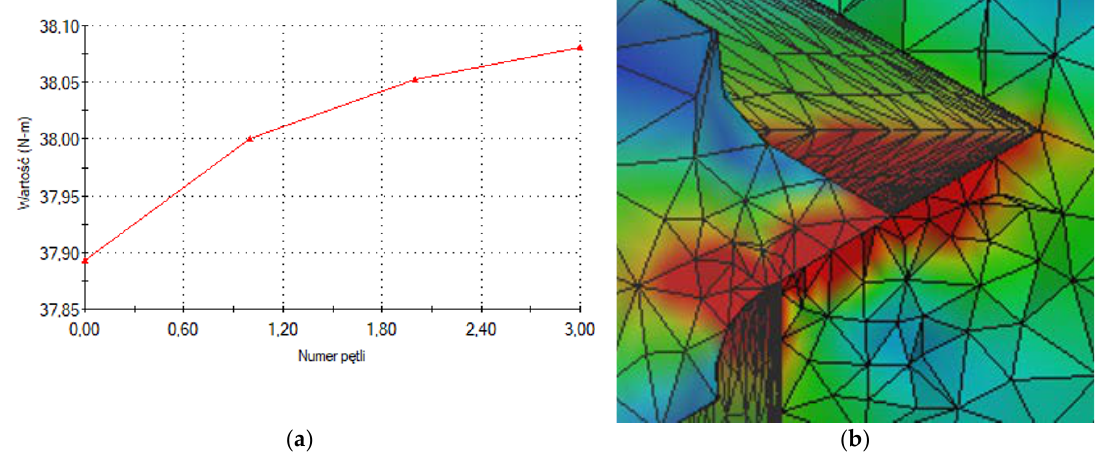
Figure 6. The outcomes of the optimization algorithm as per method h: ( a ) convergence graph, ( b ) reduced stress distribution, cross-section, magnification, with a grid for the first thread pitch.